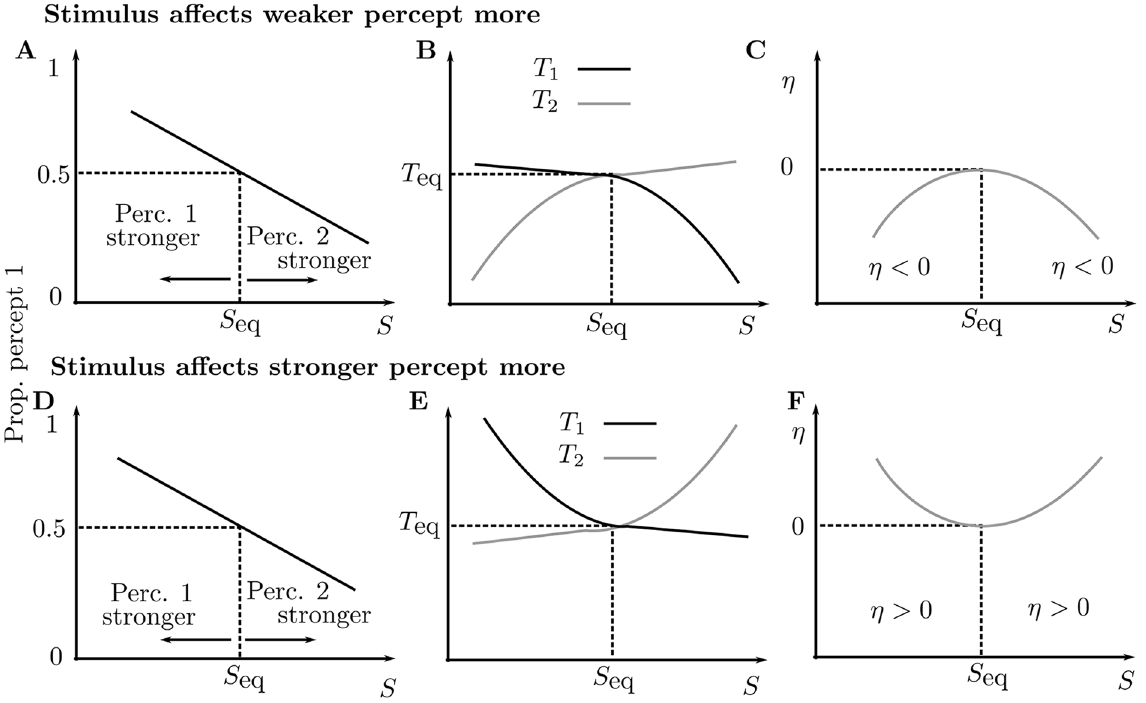
Fig 7. Scenarios for parametric dependence of perceptual dominance. Schematic diagrams illustrate how the mean percept durations may change as a stimulus parameter S is varied and dominance shifts gradually from percept 1 to percept 2. The upper row illustrates the weaker percept being affected more and the lower row the stronger percept being affected more. A,D : Proportion of time when percept 1 is dominant decreases monotonically through equidominance (0.5) (dashed lines) in both scenarios. When S < S eq percept 1 is stronger, when S > S eq percept 2 is stronger. B,E : Percept durations are equal ( T 1 = T 2 = T eq ) at equidominance ( S = S eq ) in both scenarios. When the weaker percept is affected more the lower branches decrease more on either side of equidominance ( B ). When the stronger percept is affected more the upper branches increase more on either side of equidominance ( E ). C,F : The measure η (defined by Eq (3)) is zero at equidominance ( S = S eq ) for both scenarios. It decreases on either side of equidominance when the weaker percept is affected more ( C ) and increases on either side of equidominance when the stronger percept is affected more ( F